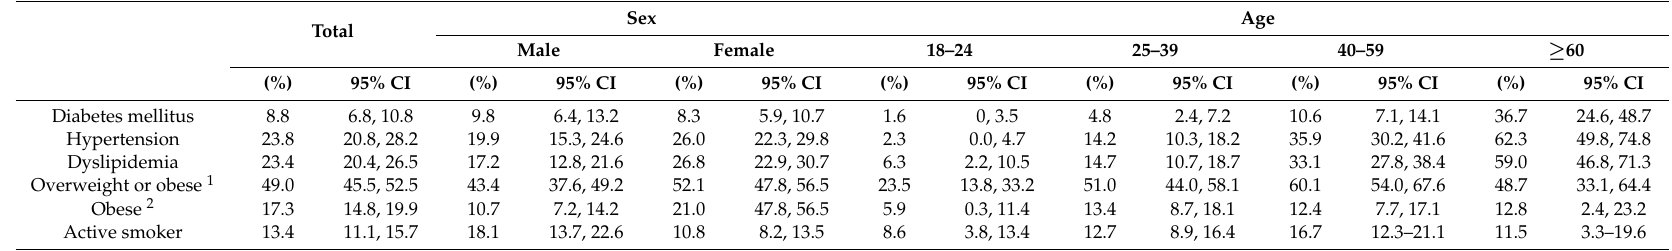
Table 2. Unadjusted total, sex-, and age-specific prevalences of non-communicable diseases (NCDs) and NCD risk factors in the community of Pau da Lima, Salvador, Brazil, 2010. Sex Age Total Male